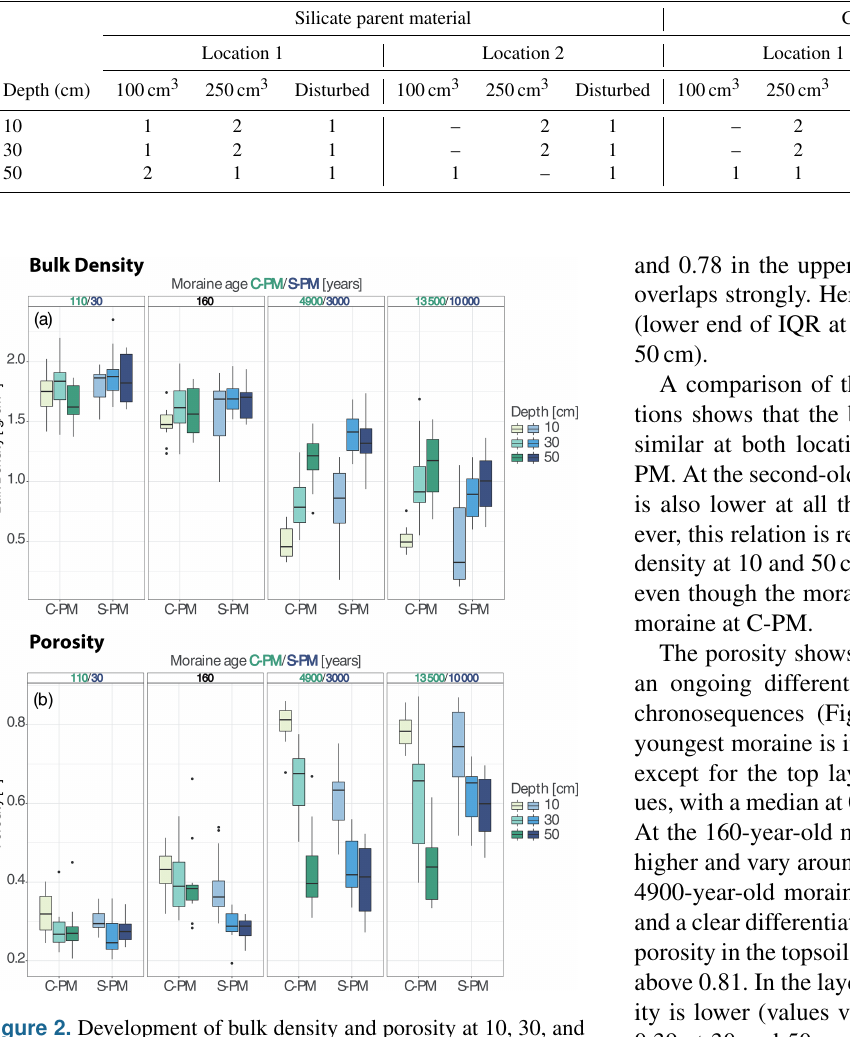
Table 2. Overview of the sampling scheme at each sampling site for both parent materials. The two sampling locations per sampling site are denoted as Location 1 and Location 2. Locations 1 and 2 were 3–4m apart. The volume of the sample rings is given in the respective headers, and the corresponding numbers of samples are provided for each soil depth.